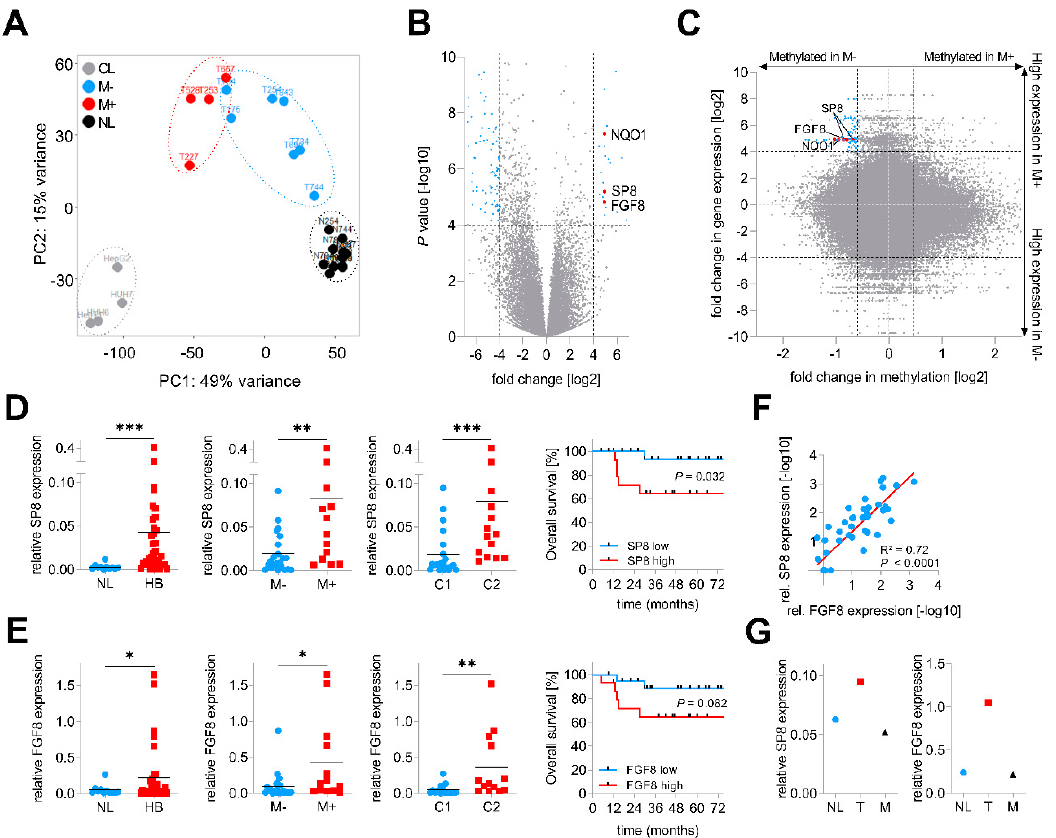
Figure 1. Identification of SP8 as a metastasis-associated marker of hepatoblastoma (HB). ( A ) principal component analysis of RNA sequencing-based expression data from 11 normal liver samples (NL, depicted in black), 7 non-metastasized (M − , in blue), 4 metastasized (M + , in red) primary tumors and 4 liver tumor cell lines (CL, in grey); ( B ) volcano plot displaying genes that are di ff erentially expressed between M + and M − tumors. Each gene is plotted with log2-fold expression change on the x-axis and negative log10 p -value on the y-axis. Genes with an absolute log2-fold change > 4 and a p -value < 0.0001 are shown in blue. Candidate genes NQO1 , SP8 and FGF8 are highlighted in red; ( C ) scatterplot with all CpG probes showing the correlation of promoter methylation and RNA expression between the M + and M − subgroup. Genes with a fold change in methylation ≤ − 1.5 and log2-fold expression change ≥ 4 are indicated in blue. CpG probes associated with SP8, FGF8 and NQO1 are indicated in red. ( D ) SP8 and ( E ) FGF8 expression levels were measured by Q-PCR, normalized to the house-keeping gene TBP , and categorized into NL and HB specimens, M − and M + tumors, and the C1 and C2 subtype of the 16-gene signature [11]. Statistical significance of all experiments was calculated using the Mann–Whitney test ( p < 0.05). Overall survival was calculated as time from diagnosis to death of the disease and is plotted for 35 HB patients. Statistical significance was calculated using the Mantel–Cox test; ( F ) correlation of SP8 and FGF8 expression in 35 tumor and 11 normal liver samples. Dots represent − log10 values of relative SP8 expression plotted versus − log10 values of relative FGF8 expression; ( G ) SP8 and FGF8 expression measured by Q-PCR and normalized to the house-keeping gene TBP in a patient with surgically removed metastasis (M) and primary tumor (T) with adjacent normal liver (NL). * p < 0.05, ** p < 0.01, *** p < 0.001.